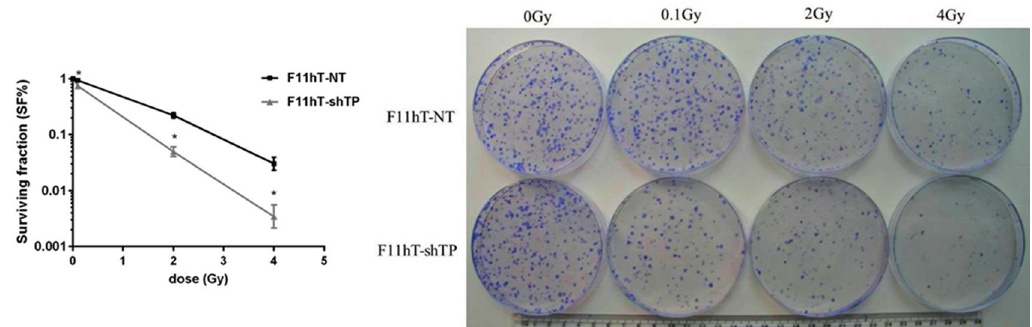
Figure 3. Radiation survival curve of the F11hT-NT and F11hT-shTP cell lines. On the